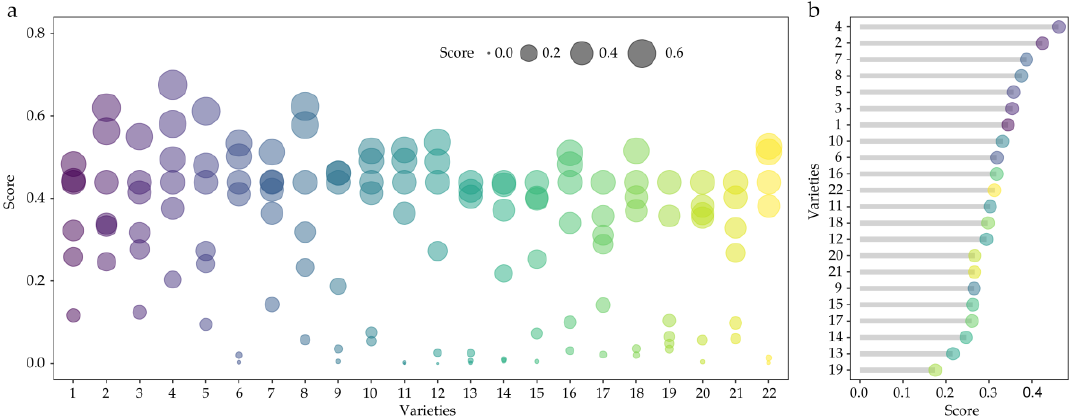
Figure 1. Comprehensive evaluation of the autotoxic effect of 22 alfalfa varieties exposed to six leaf extract concentrations. ( a ) Under six concentrations, the seven germination indexes of the 22 varieties are relative to the comprehensive score of CK. 1–22 represent twenty-two alfalfa varieties, and each circle represents each treatment concentration. ( b ) Comprehensive score ranking of 22 varieties.